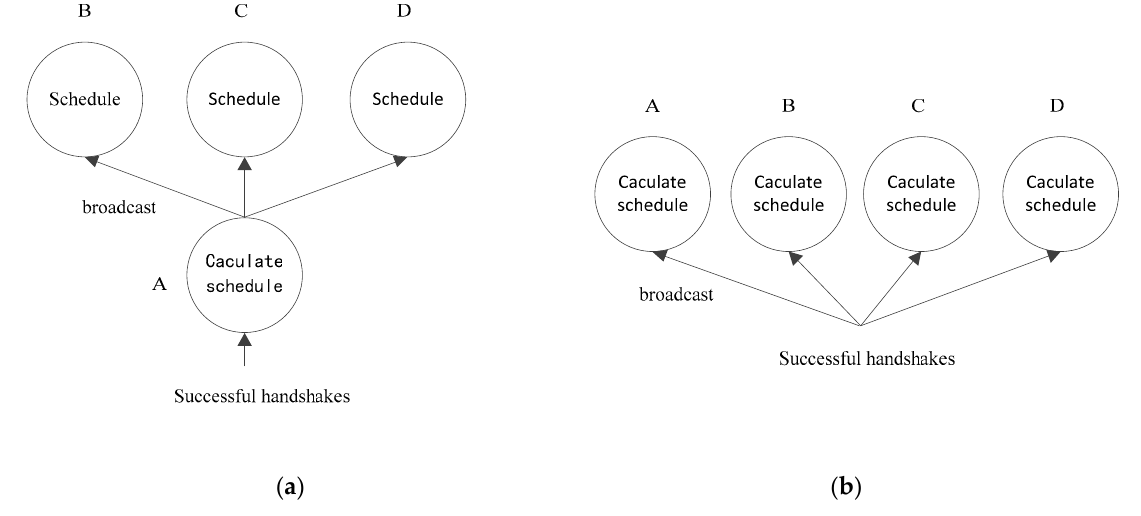
Figure 6. Applying replication computation to parallel data transmission. ( a ) conventional method; ( b ) replication computation.